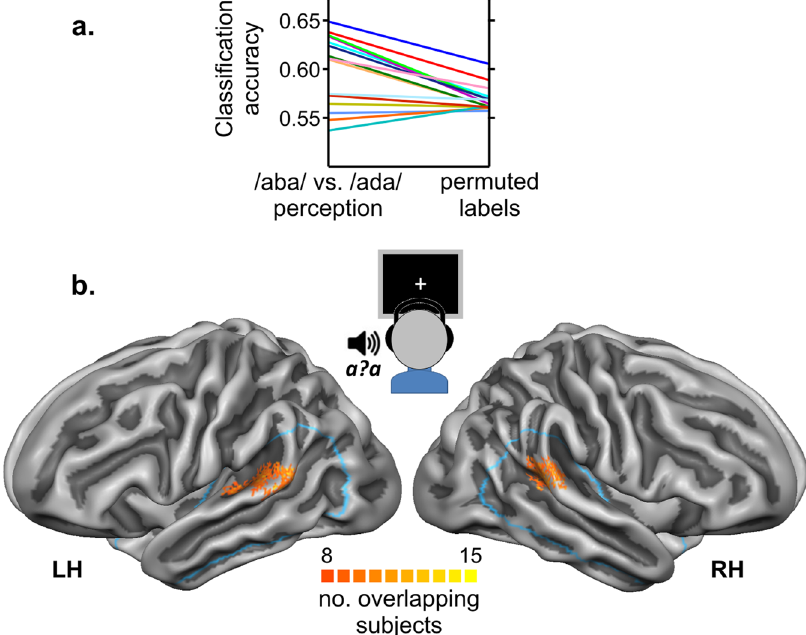
Figure 4. fMRI decoding of the auditory post-test trials. ( a ) Classification accuracies for each of our 15 individual participants. Accuracies obtained with the perceptual labels (/aba/ vs. /ada/ perception) were significantly higher (p = 0.0043) than the accuracies based on permuted labels following the exact same decoding procedure. ( b ) Discriminative maps that illustrate for how many subjects vertices were among the 20% most discriminative features for decoding /aba/ vs. /ada/ perception. Blue outlines delineate the anatomical temporal cortex masks (ROIs) within which fMRI decoding was performed. Maps are visualized on the aligned group-averaged cortical surface representations of the left (LH) and right (RH)